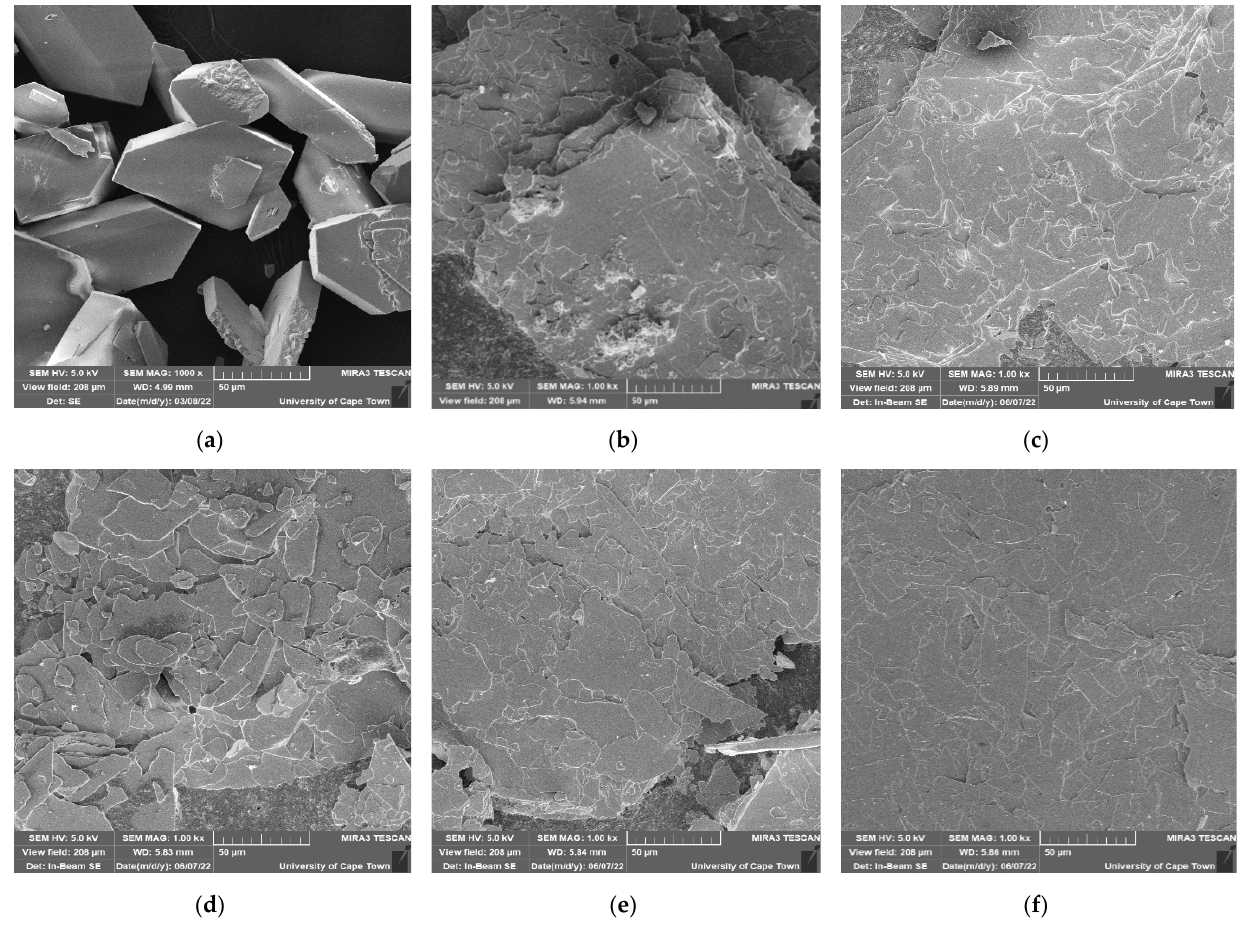
Figure 10. SEM micrographs of Nd 2 (SO 4 ) 3 .8H 2 O crystals at a magnification of 1000 ×. Scale bar of 50 µm ( a ) Nd 2 (SO 4 ) 3 .8H 2 O seeds; ( b ) Unseeded; ( c ) C S = 0.64%; ( d ) C S = 5%; ( e ) C S = 10%; and ( f ) C S = 20%.